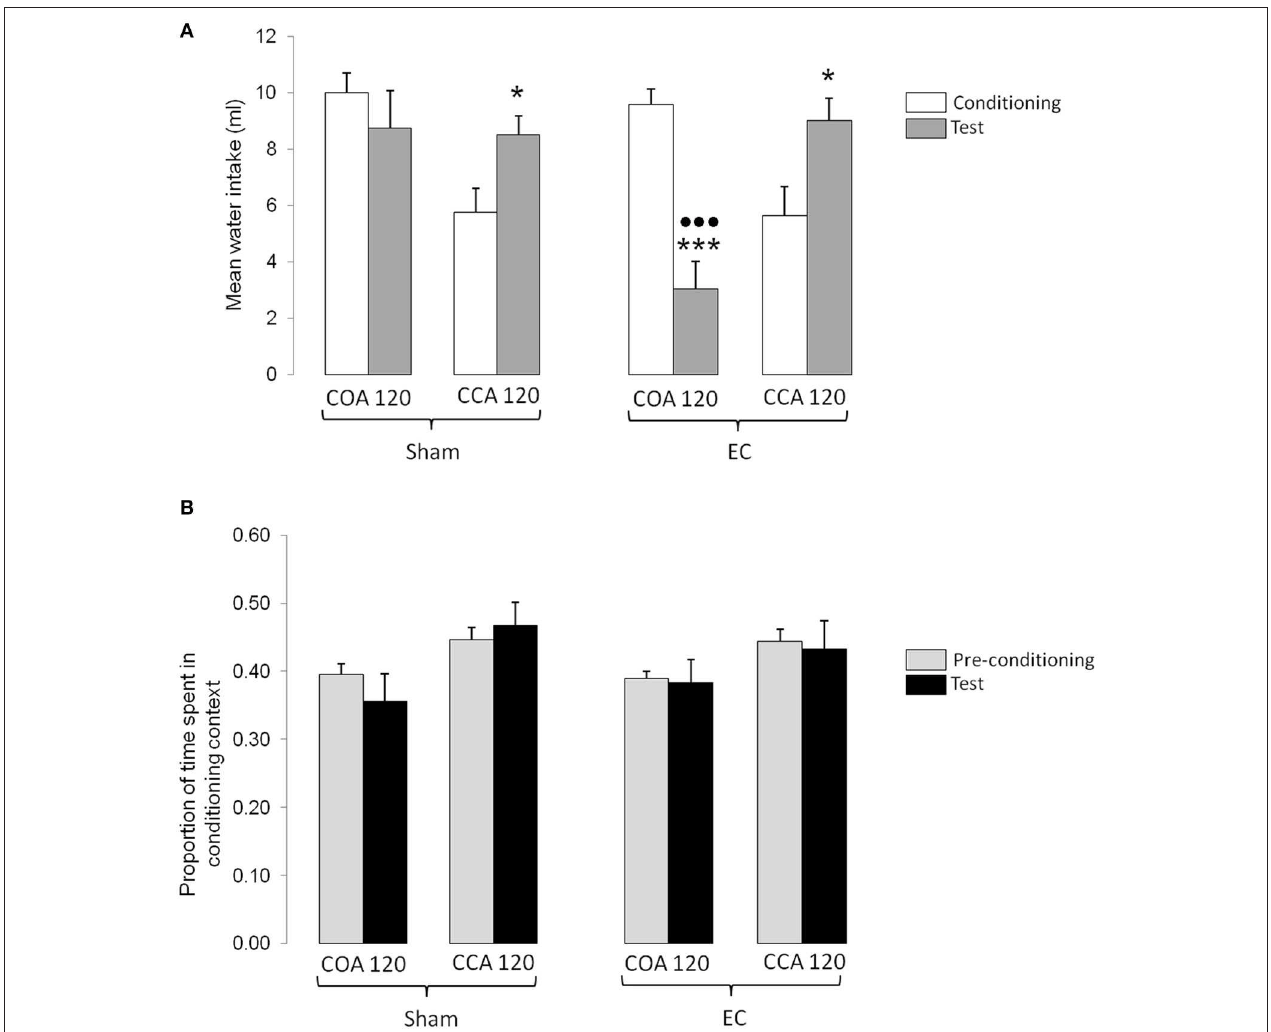
FIGURE 4 | Effect of a long ISI on COA and CCA in Sham- and EC-lesioned groups. (A) Represents the mean odorized water intakes ( ± S.E.M.) measured during the conditioning (white bars) and testing (gray bars) sessions in each experimental group. * , *** p < 0.05 and 0.001 as compared with the amount of odorized water intake during conditioning ; p < 0.001 as compared with the amount of odorized water intake during testing in all the other groups. (B) represents the mean proportion of time ( ± S.E.M.) spent in the conditioning context for each experimental group. Bars represent the proportion of time spent in the conditioning context (mean time spent in the conditioning context/time of the session) calculated in the pre-conditioning (gray bars) and testing (black) sessions. EC, lesion of the entorhinal cortex; Control, sham-lesion of the entorhinal cortex; COA, conditioned odor aversion; CCA, conditioned context